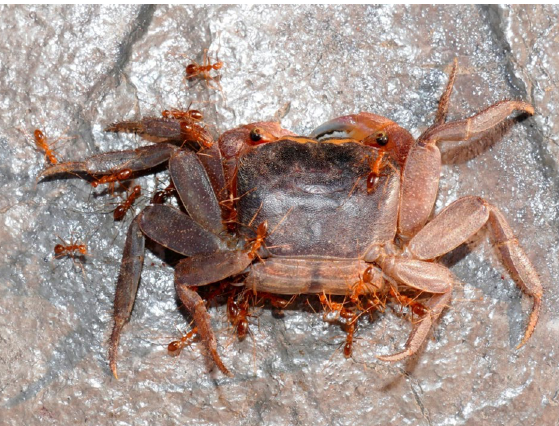
Figure 5. Metasesarma aubryi swarmed by Anoplolepis gracilipes workers during migration towards the